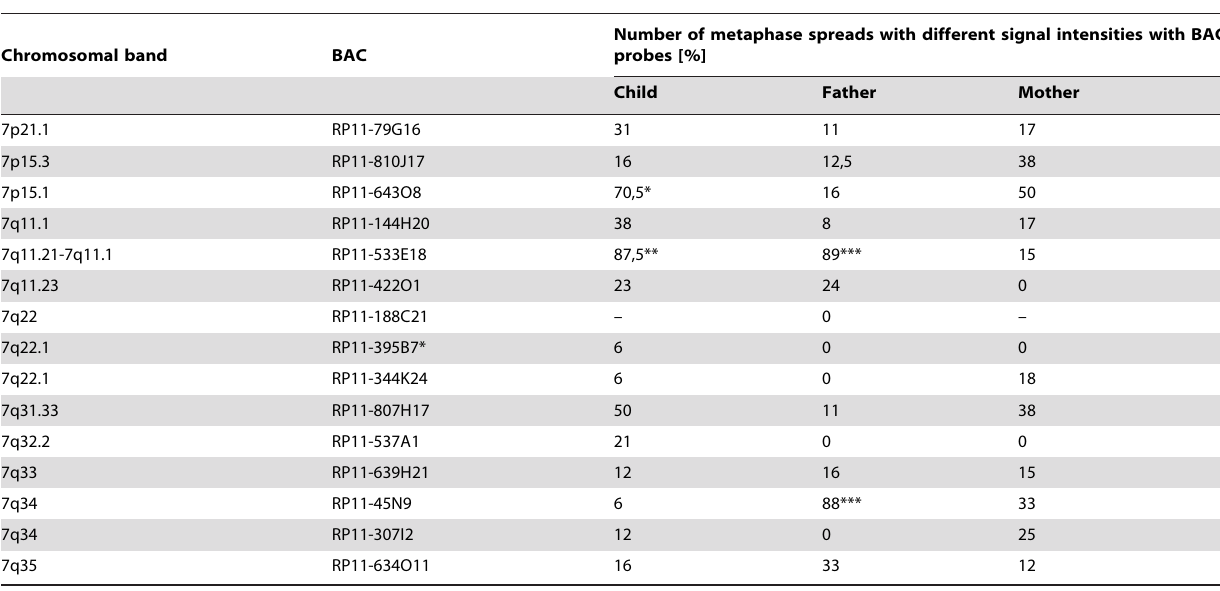
Table 1. pod-FISH analysis of der(7)t(Y;7) in an individual with Turner syndrome.